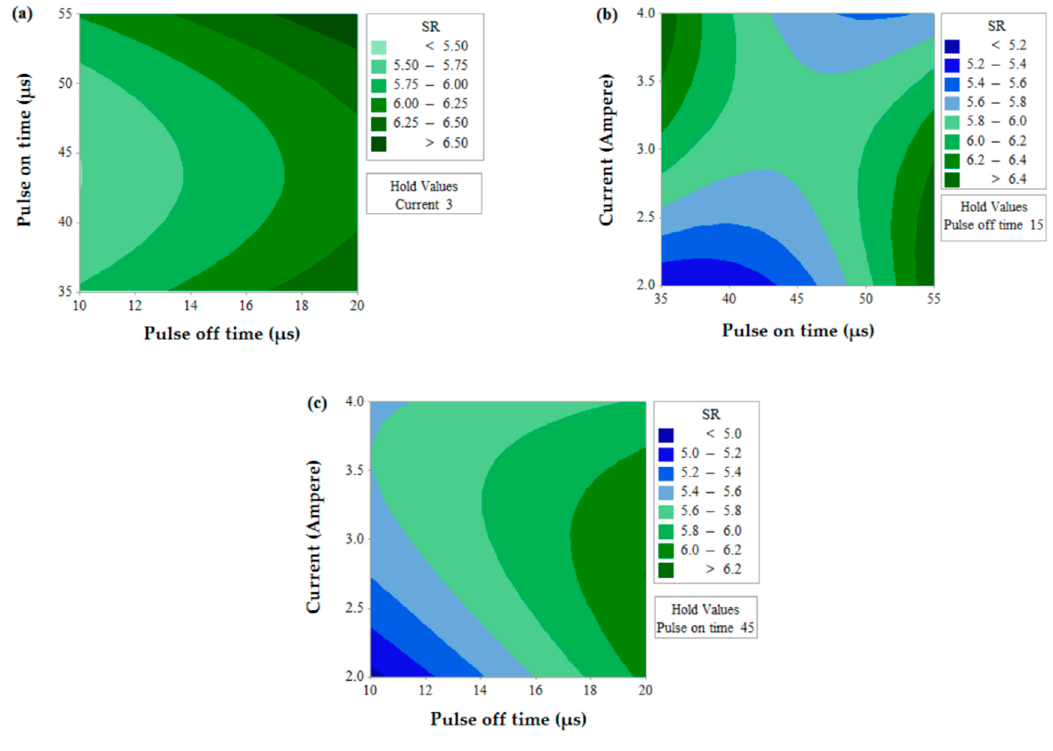
Figure 7. Contour plot for SR.